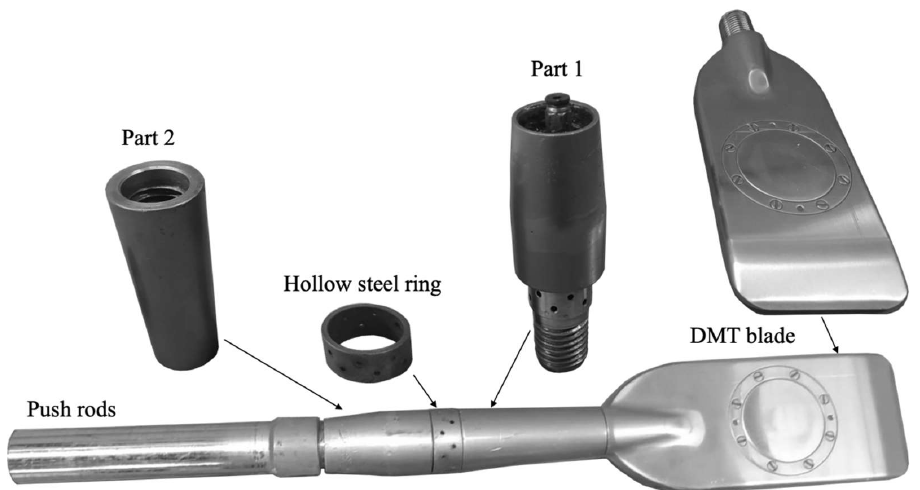
Figure 1. Parts of inundation device and system attached to the DMT blade. Adapted from [32].